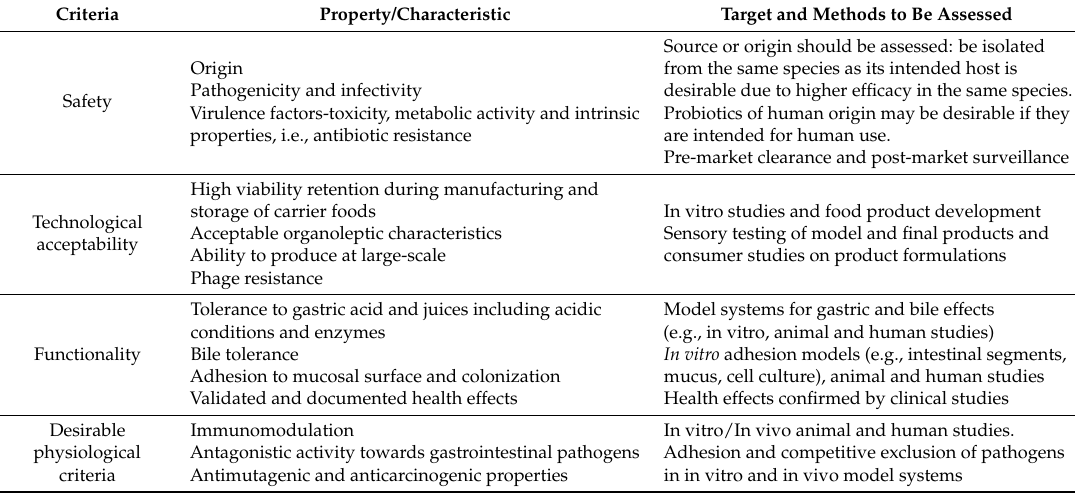
Table 3. Key and desirable criteria for the selection of probiotics in food and nutraceutical